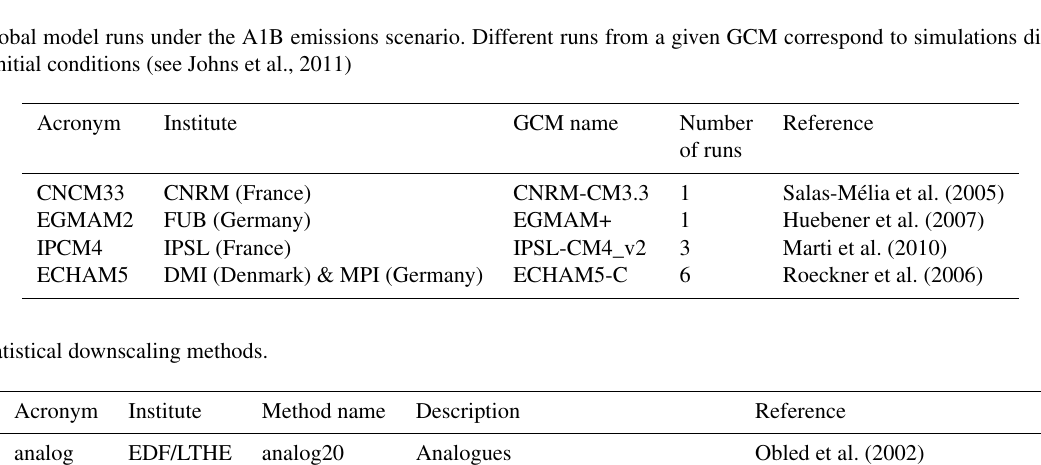
Table 1. Global model runs under the A1B emissions scenario. Different runs from a given GCM correspond to simulations differing only from their initial conditions (see Johns et al., 2011)